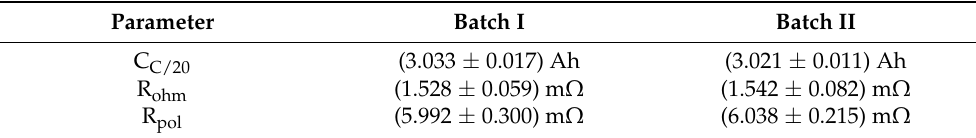
Table 1. Mean cell parameters and their deviation at beginning of life.